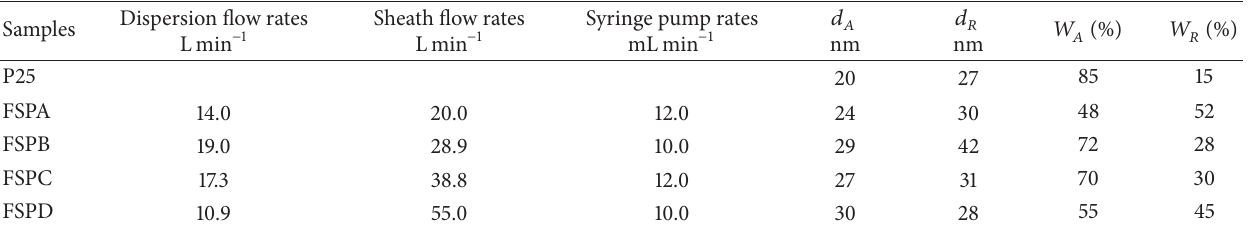
Table 1: Anatase ( 𝑊 𝐴 %) and rutile ( 𝑊 𝑅 %) compositions, crystallite sizes ( 𝑑 𝐴 and 𝑑 𝑅 ) under different sheath, dispersion oxygen fractions, and syringe pump flow rates. Samples